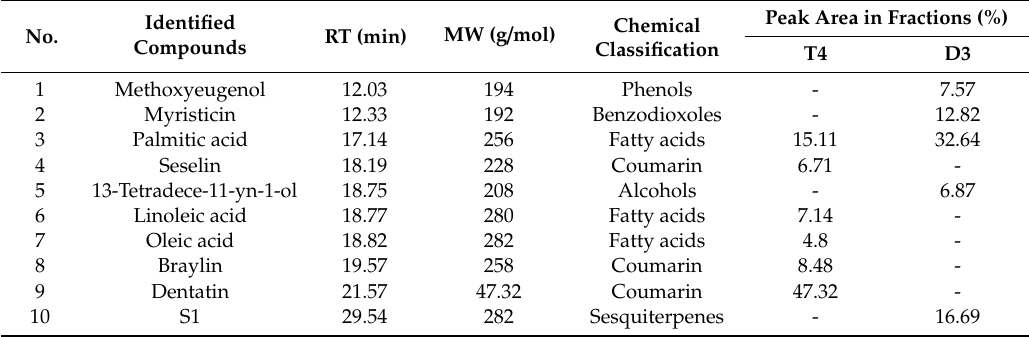
Table 5. Major phytoconstituents in the most active fractions T4 and